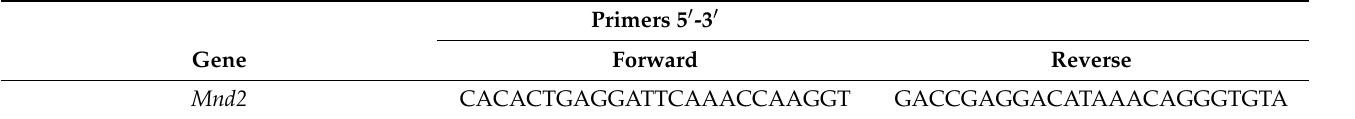
Table 1. Primer Sequences for genotype identification. Primers 5 (cid:48) -3